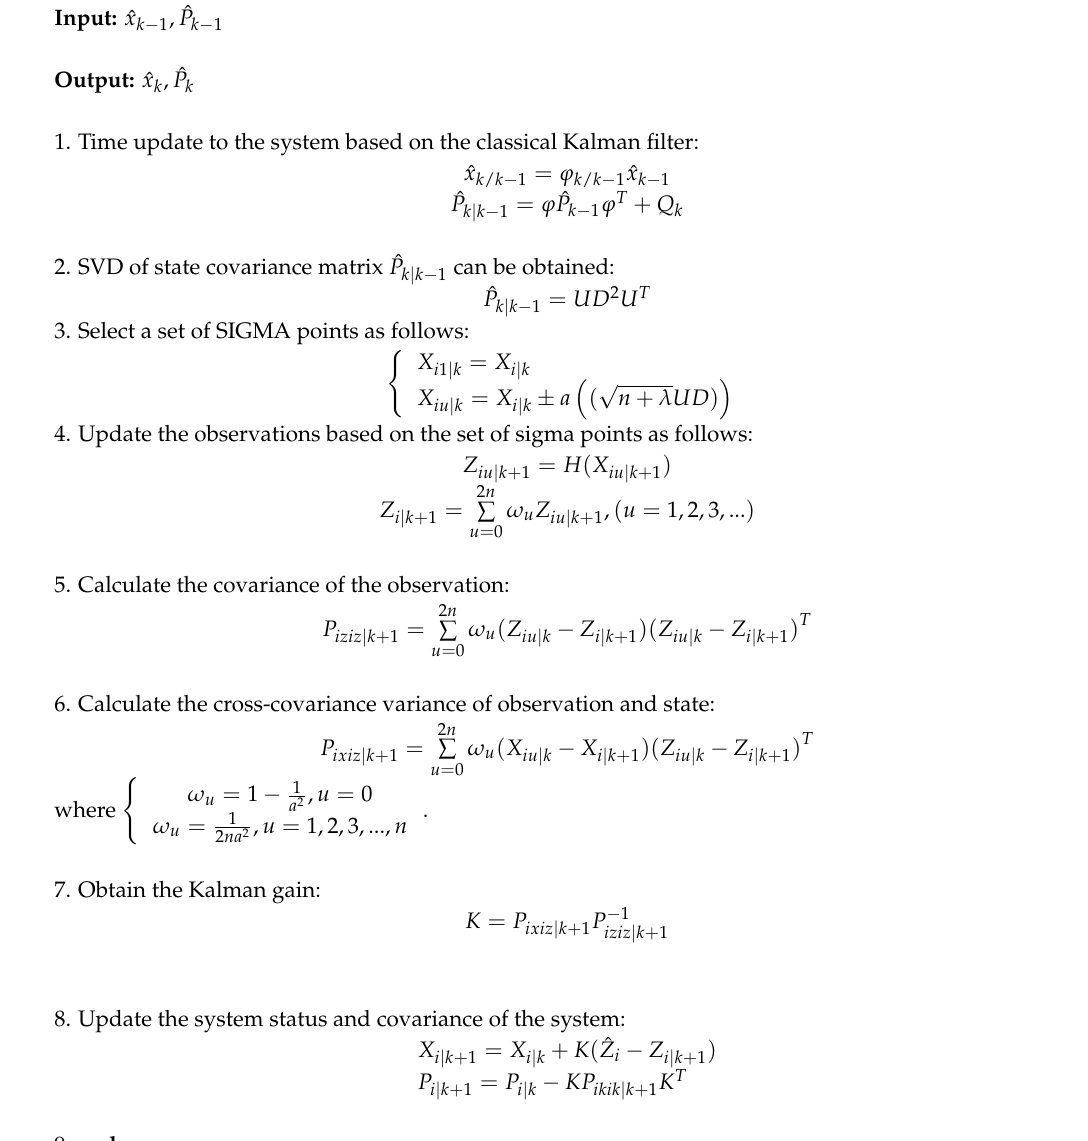
Algorithm 1: The flow of the derivative SVD-DUKF